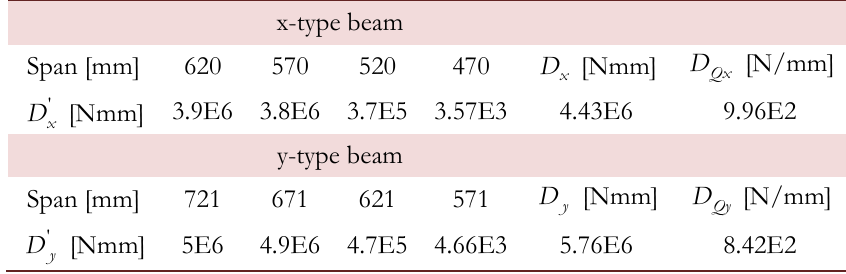
Table 3: Results of TPB tests on x- and y-type sandwich beams: apparent and corrected values of